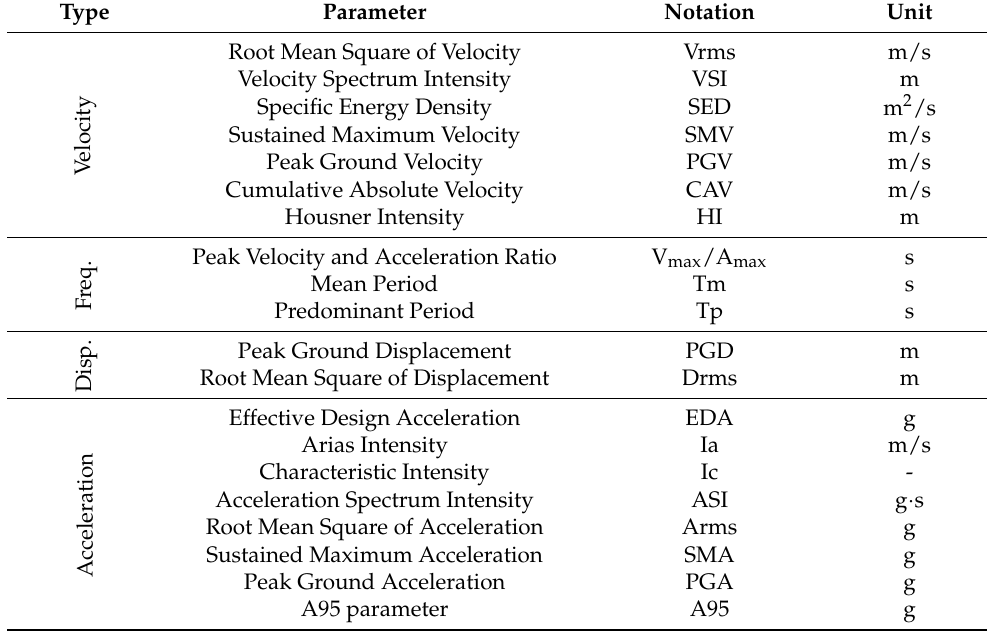
Table 1. Ground motion